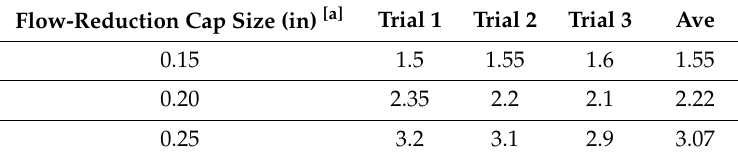
Table 5. Flowrate (mL min − 1 ) through flow-reduction